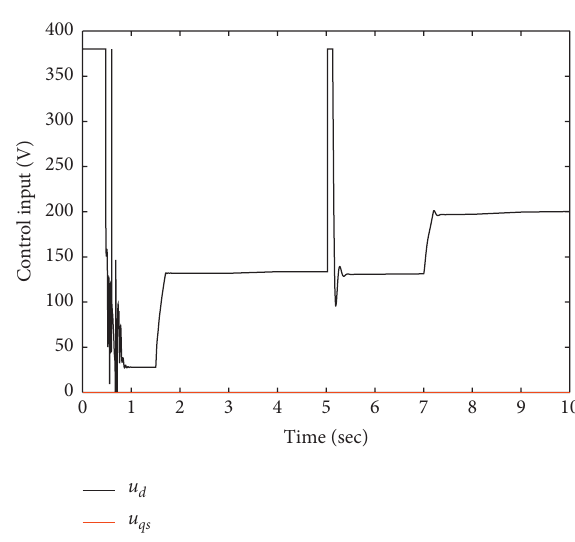
Figure 7: Evolution of control inputs.